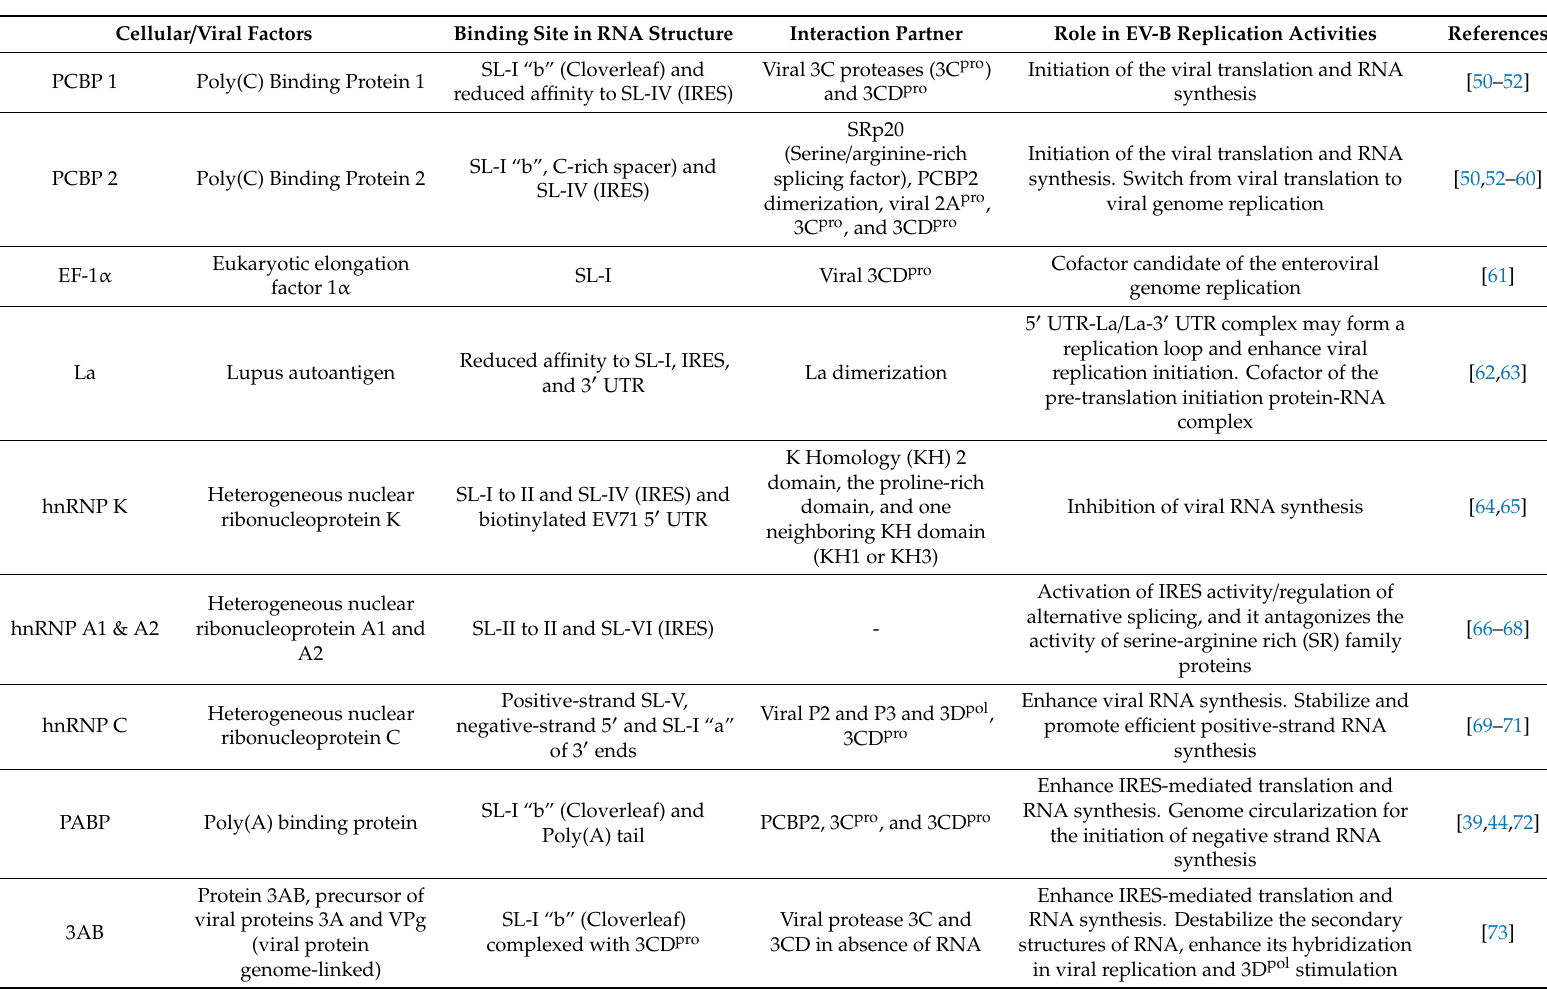
Table 1. Cellular and viral factors involved in the formation of ribonucleoprotein complexes in group-B enterovirus genomic replication or translation